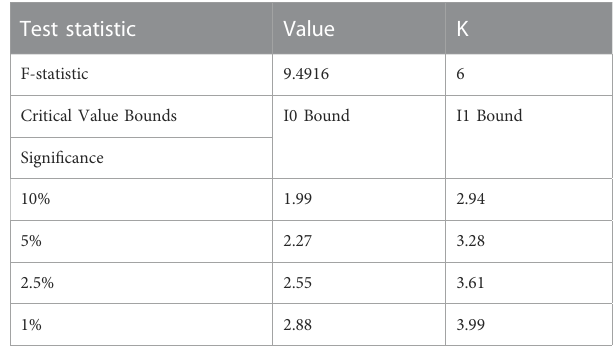
TABLE 6 Results of the ARDL Bound